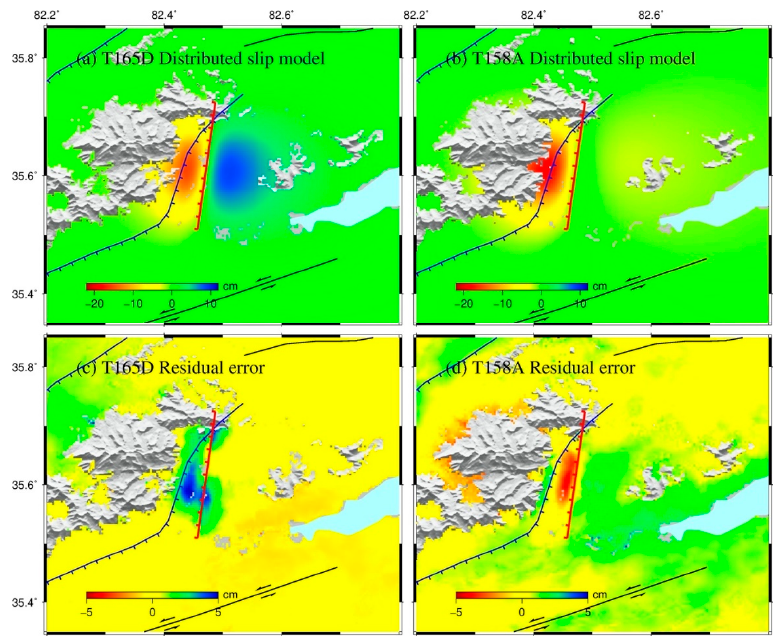
Figure 10. ( a,b ) Models and ( c,d ) their residual displacement for each interferogram based on the distributed slip model in Table 1. The red line indicates the fault line extended for distributed slip model inversion.